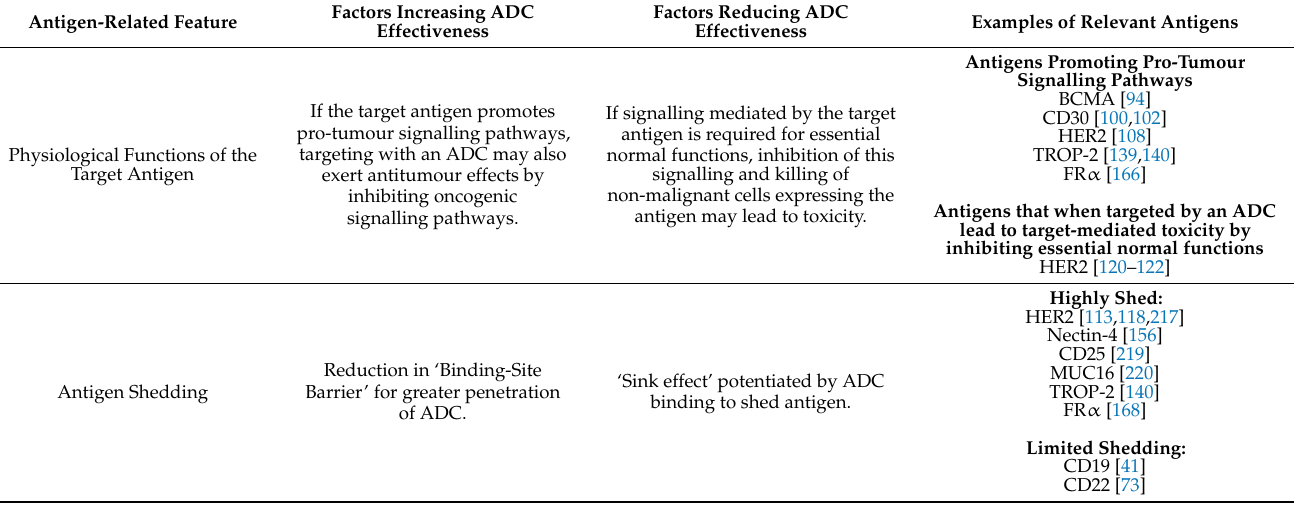
Table 5. Summary of Antigen-Related Features that may affect ADC